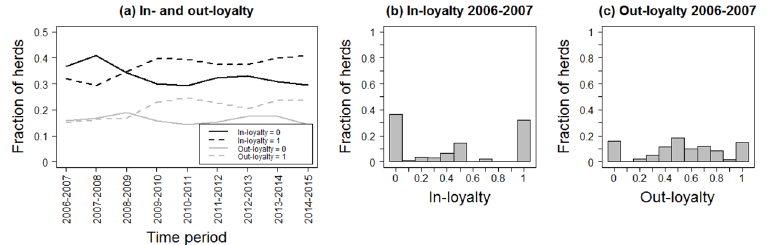
Fig 5. In- and out-loyalty patterns. (a) Fraction of holdingswith in-loyalty and out-loyalty equal to 0 and 1 for the wholenetwork of pig movements from 1 st January2006 to 31 st December 2015 in Denmark. (b) and (c) show the histograms of in- and out-loyaltyfor the two consecutive years 2006 and 2007. Both histograms refer to the years 2006 and 2007 for visualization purposes, all other distributions show stability over time and are shown in in S2